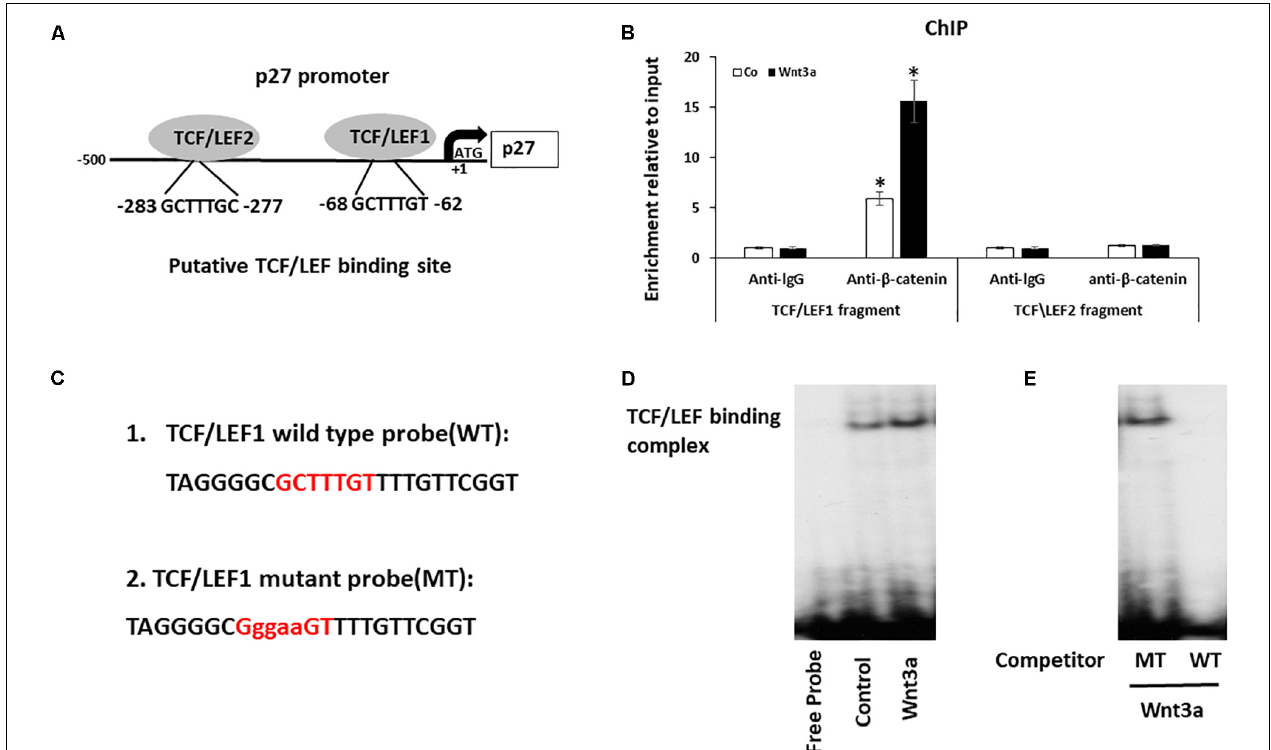
FIGURE 5 | Wnt signaling induces cell cycle inhibitor p27 by direct binding to promoter. (A) Analysis of the p27 promoter region and two putative TCF/LEF binding sites were identified. (B) Cross-linked chromatin was isolated from cells treated with Wnt3a for 3-days and immunoprecipitated with anti- β -catenin antibody. Enrichment of immunoprecipitated chromatin was quantified by Quantitative PCR (qPCR) of two regions of the p27 promoter, amplicons 1 and 2, the positions of which are indicated in the p27 gene schematic. Results are mean ± SD. All experiments were performed in triplicate. ∗ P < 0.05 vs. anti-lgG controls. (C) The 32 P-ATP radiolabeled oligonucleotides corresponding to the TCF/LEF1 site in p27 promoter were used in Gel-shift assay. (D) Gel-shift assay using nuclear extracts isolated from Wnt3a treated cells were incubated with 32 P − ATP radiolabeled double stranded oligonucleotide spanning the TCF/LEF1 response element. (E) Gel-shift assay showed the protein/DNA interaction is competed by self-cold oligo at a 100-fold excess (WT) but not with the cold TCF/LEF1 mutated oligo at a 100-fold excess